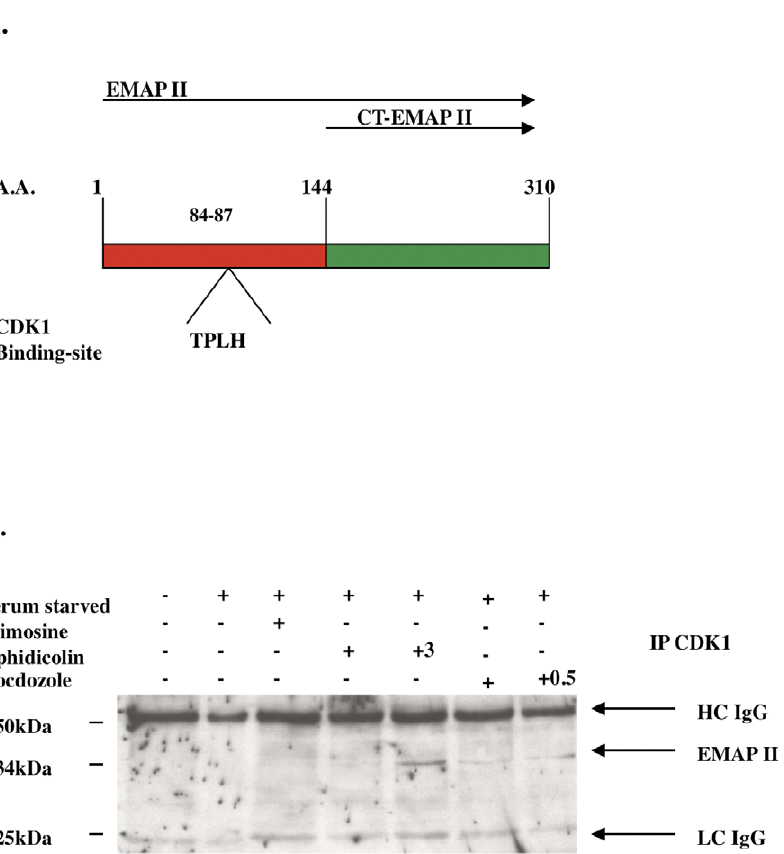
Figure 5. EMAP II contains a Cdk1 binding site and immuno-precipitates with Cdk1 during S and G2M phases of cell cycle. A Cdk1 binding domain, TPLH, was identified in EMAP II’s N-terminal region at aa 84–87 (A). Immunoprecipitation using Cdk1 determined that EMAP II binds to Cdk1 during S and G2M phase of cell cycle (B) (these experiments were performed 4 times).